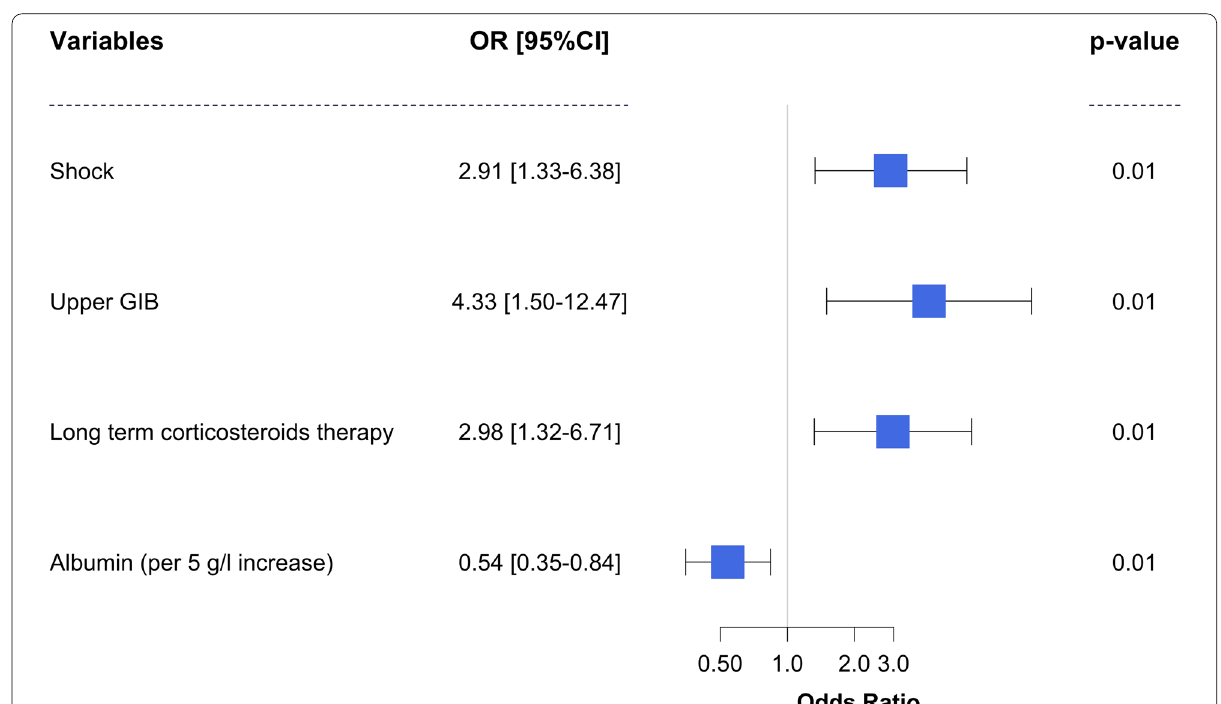
Fig. 3 Factors associated with mortality by multivariate analysis. GIB gastrointestinal